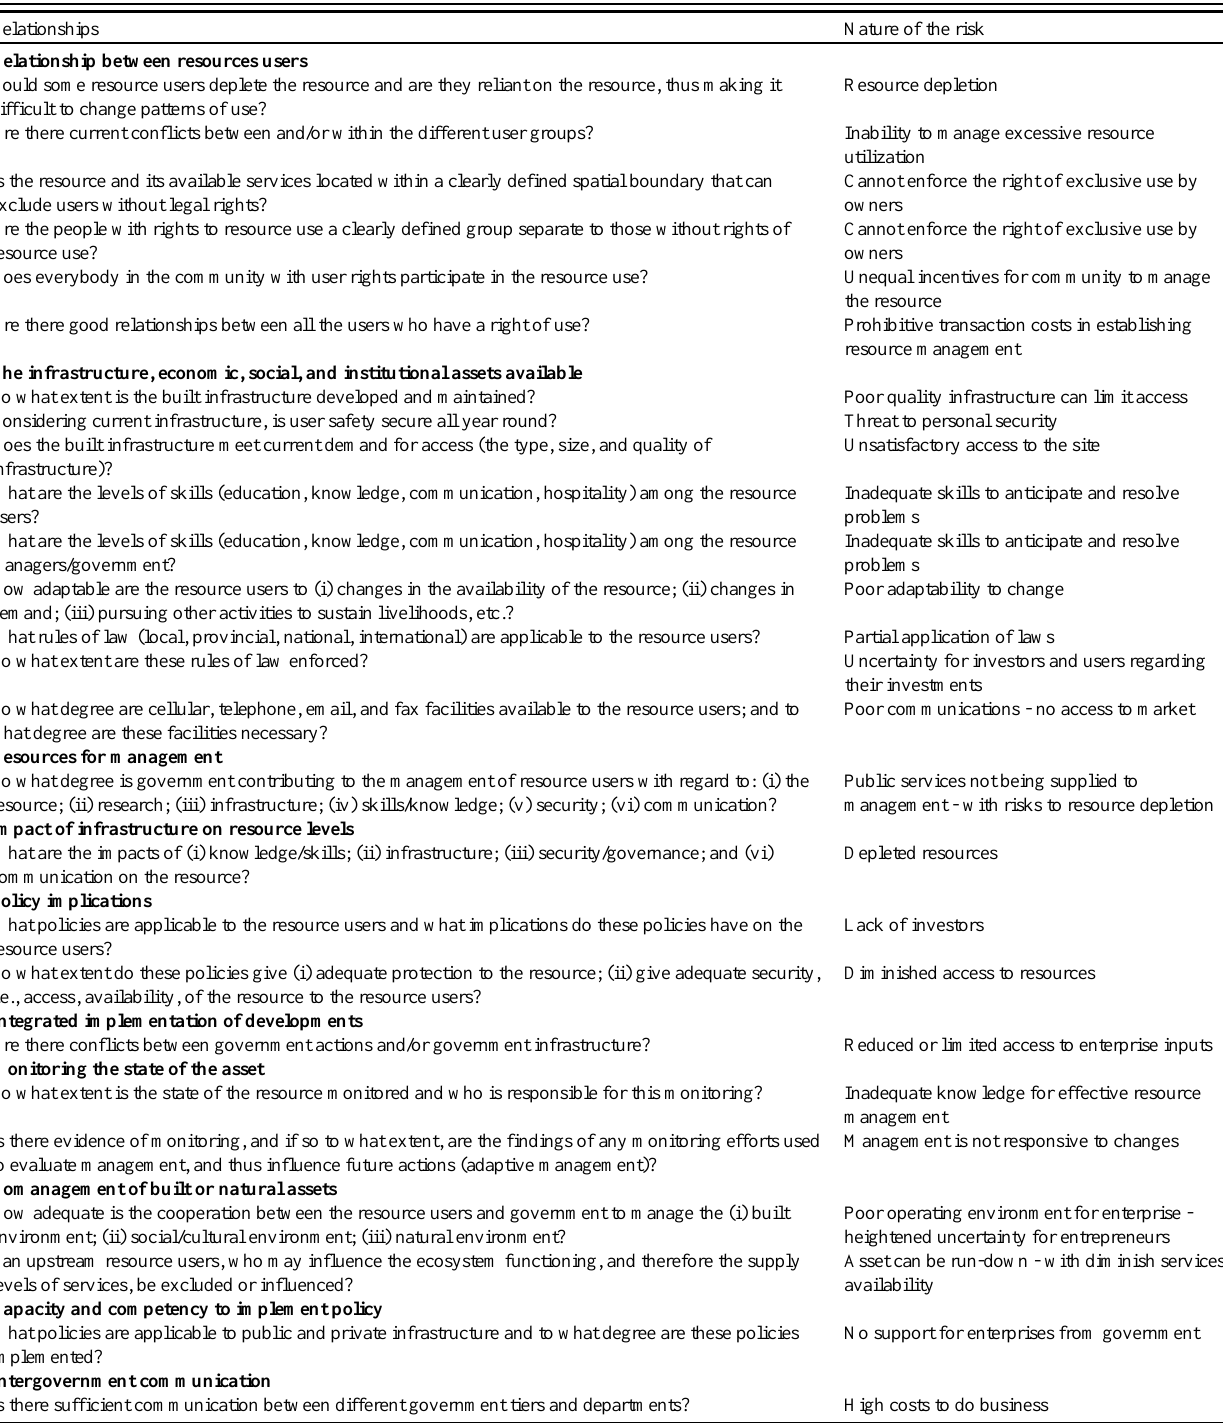
Table 4 . Risk Assessment (source: Bowd et al.